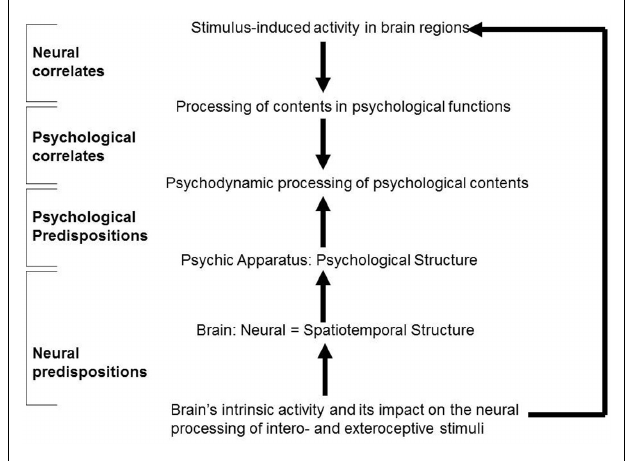
FIGURE 3 | “Neural correlates” versus “neural